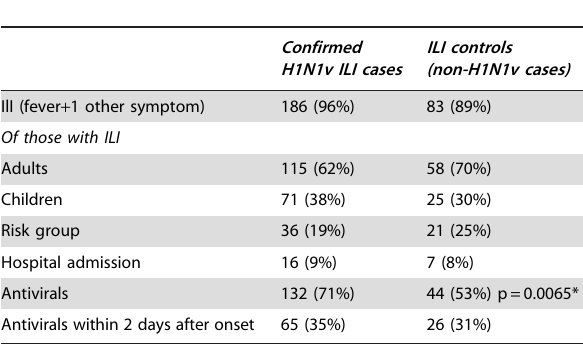
Table 1. Background characteristic of patients.